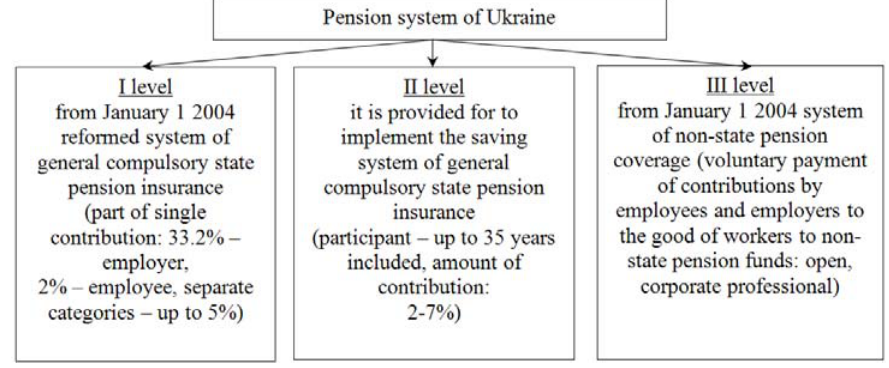
Fig. 1. Pension system of Ukraine